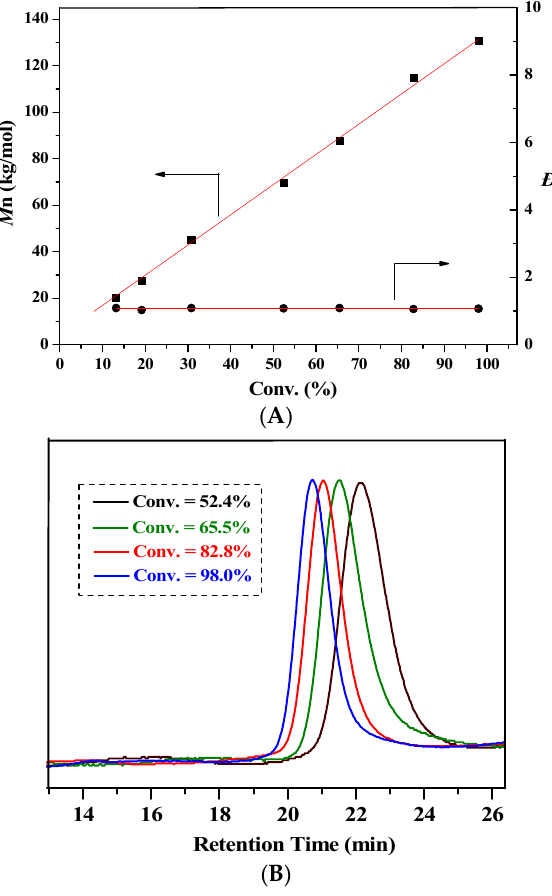
Figure 3. ( A ) Plots of M n and Đ vs. monomer conversion (%) for the MMA polymerization by i Pr NHC/Al(BHT) 2 Me. ( B ) GPC traces for PMMAs produced at different monomer